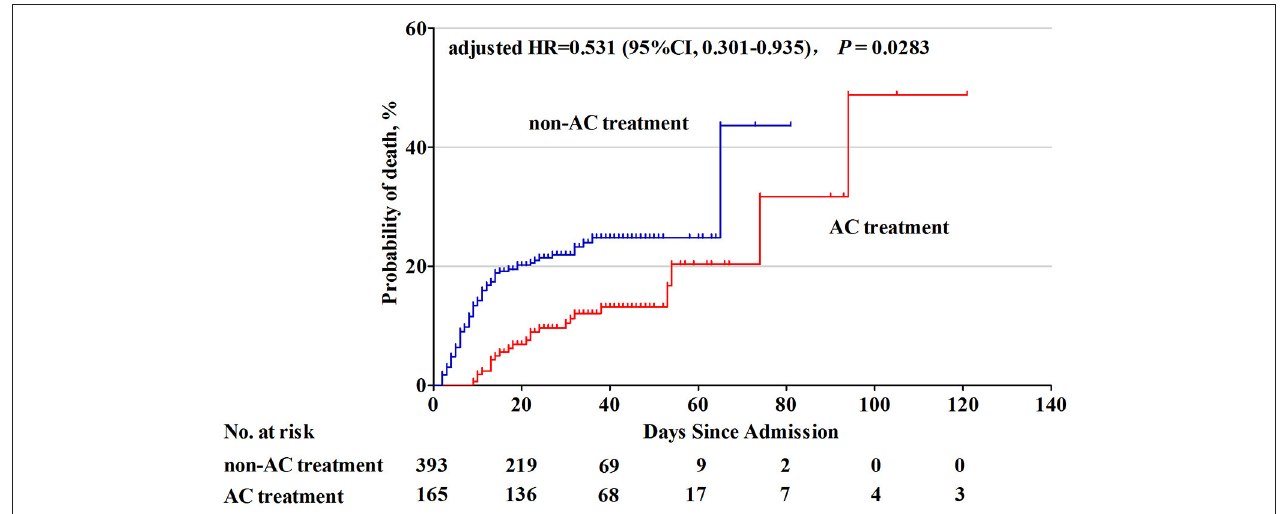
FIGURE 2 | Cumulative probability of death in COVID-19 patients with and without AC treatment. Patients with AC treatment had a lower probability of in-hospital mortality than those without AC treatment (adjusted* HR = 0.531, 95% CI: 0.301–0.935, P = 0.0283). *Adjusted for time-dependent AC exposure and baseline covariates including age, smoking, comorbidities, white blood cells, D-dimer, lactate dehydrogenase, urea, antiviral therapy, intravenous immunoglobulin, convalescent plasma therapy, and oxygen therapy in hospitalization. HR, hazard ratio; CI, confidence interval; AC,